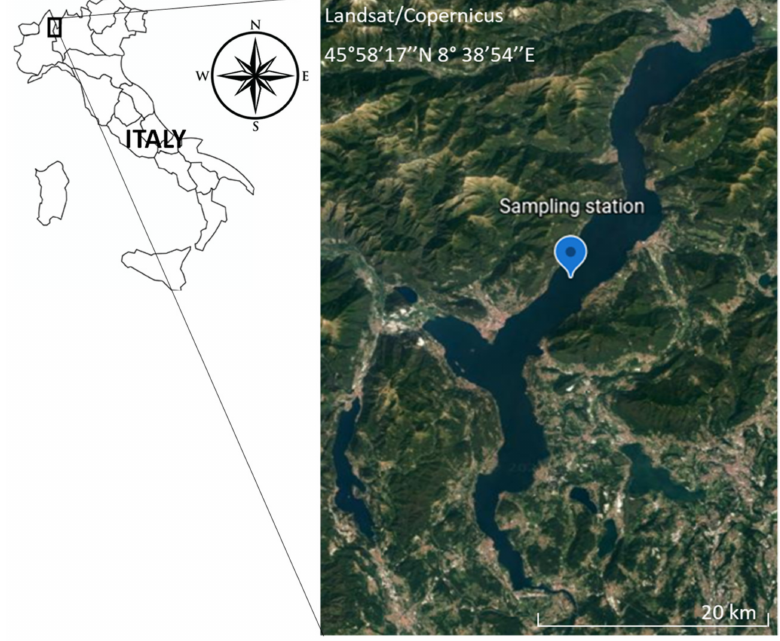
Figure 1. Map of Lake Maggiore (Northern Italy) with the sampling station. Modified from Google Earth (accessed on 14 January